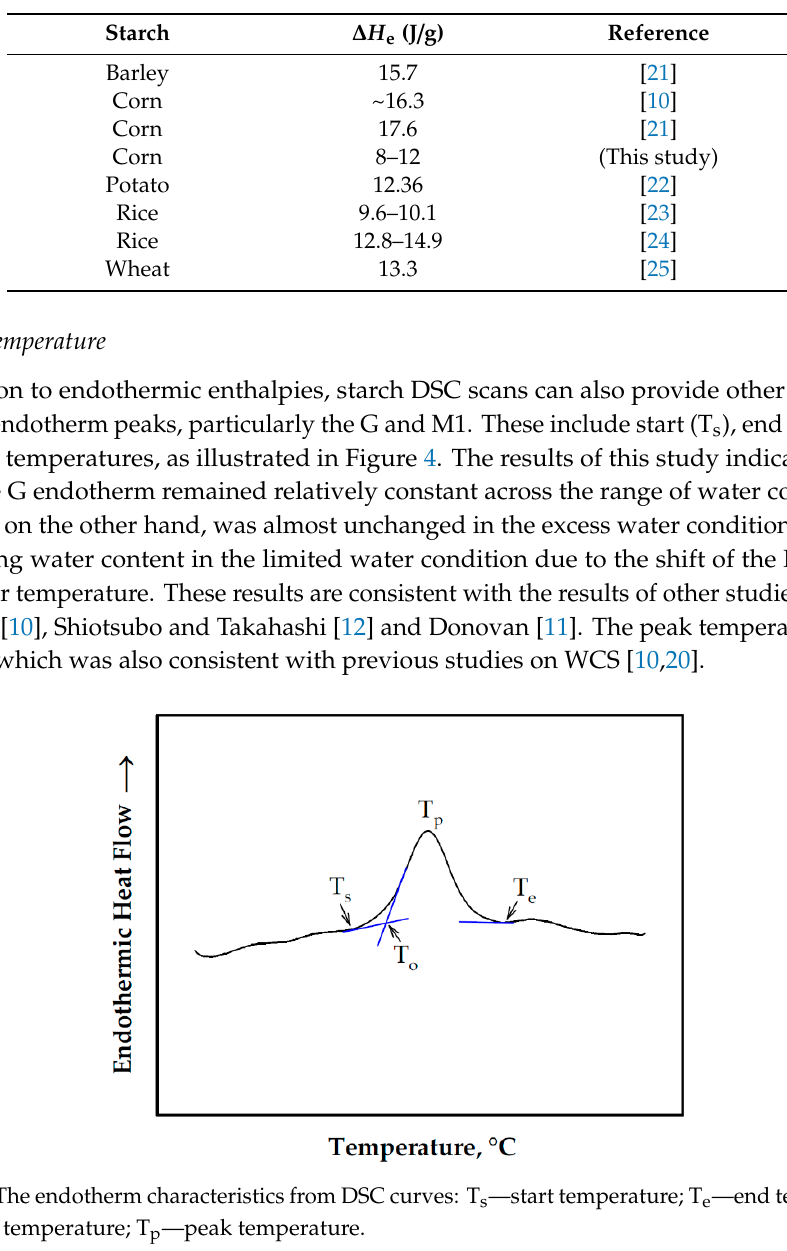
Figure 5. The gelatinization completion temperature as a function of the water content in a wet basis.